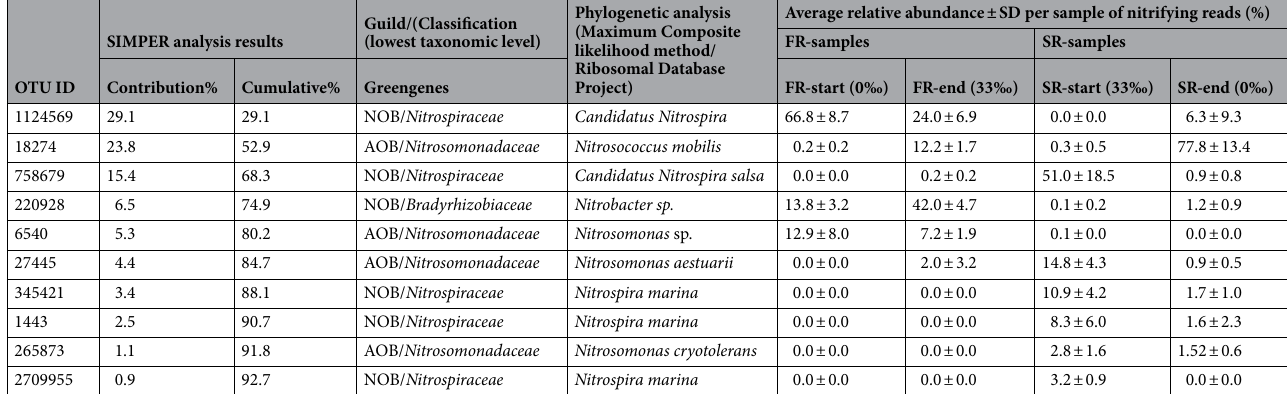
Table 2. Results from SIMPER (similarity percentage) analysis showing the ten most significant OTUs contributing to the total difference between the four groups of samples in FR and SR reactors and the contribution of these OTUs to the difference between the four groups. Also included are the results from the classification of these OTUs based on QIIME pipeline and Greengenes, and phylogenetic